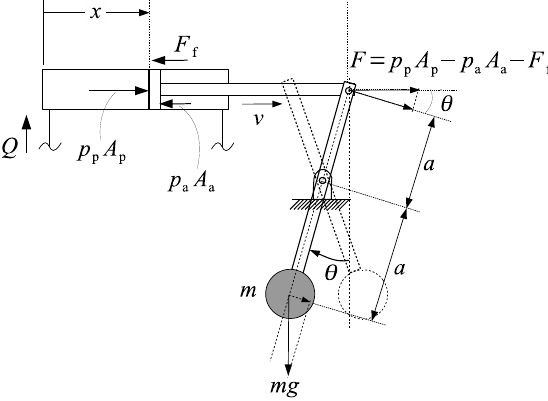
Figure 4. Pendular motion driven by a single-rod hydraulic cylinder.